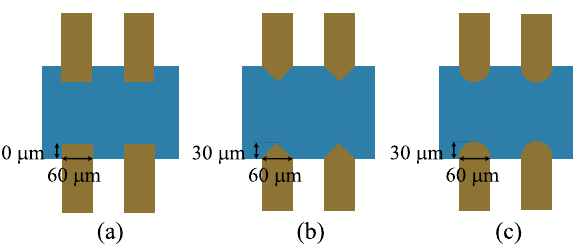
Figure 2. The configuration of investigated electrodes: ( a ) rectangular ( b ) triangular ( c )